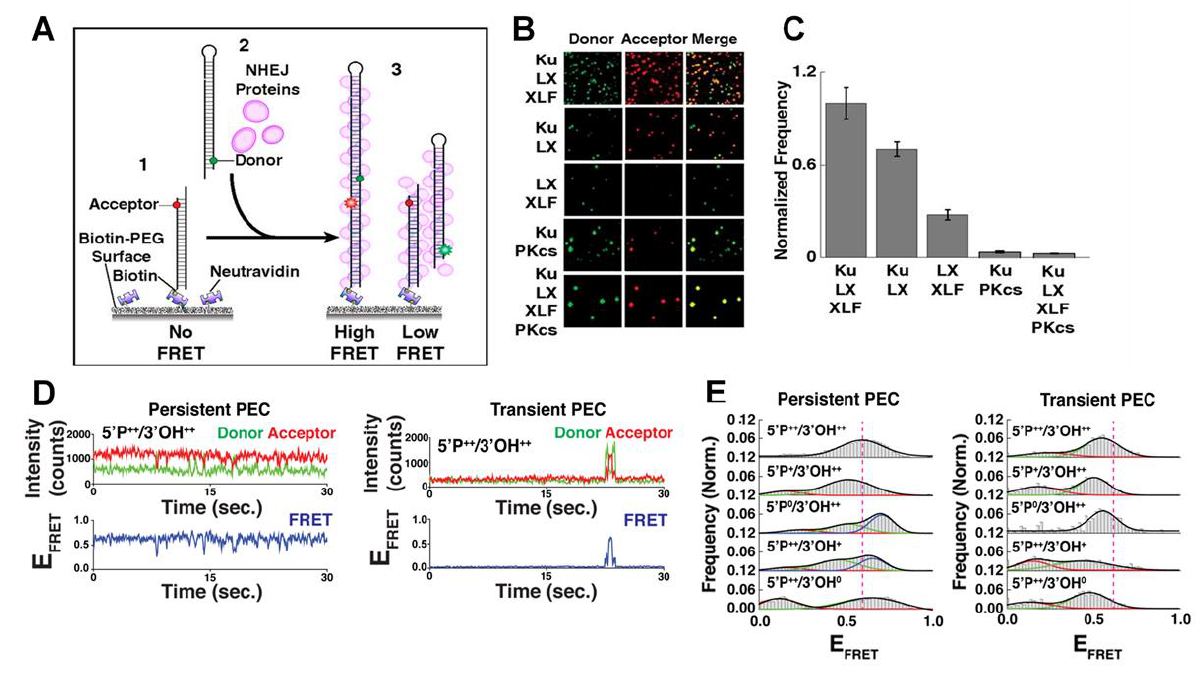
FIGURE 2: smFRET of NHEJ synapsis and ligation. (A) Schematic of the end joining smFRET assay. (1) dsDNA labelled with an acceptor dye is immobilizes to a PEG surface. (2) NHEJ proteins and a second dsDNA molecule, labelled with a donor, are added to the solution. (3) As the two ends of the DNA are joined together, FRET is observed. (B) Images showing the donor/acceptor channels for experiments that are investigating different combinations of NHEJ proteins. (C) The quantification of the number of spots in end joining experiments, from n>1000 molecules for each condition. Error bars illustrate SEM. (D) Typical smFRET traces for persistent and transient PECs. (E) Frequency distributions for FRET values of persistent and transient PECs observed with various end chemistries of dsDNAs used in the end joining assays. Reproduced from Ried et al . (2015 and 2017) [21,